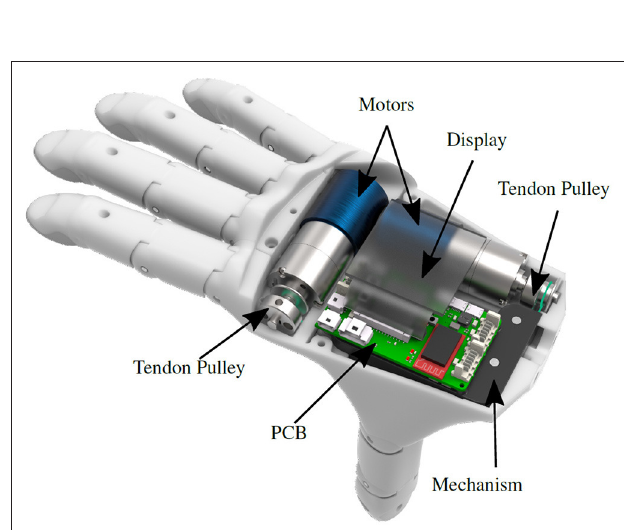
FIGURE 3 | The female prosthesis with motors, mechanism and PCB integrated into the palm. Camera and distance sensor are mounted below the mechanism. The mechanism in black is mounted below the PCB. The display is fixed on top of the PCB in the dorsal housing. The display is rendered semi-transparent to make the components underneath